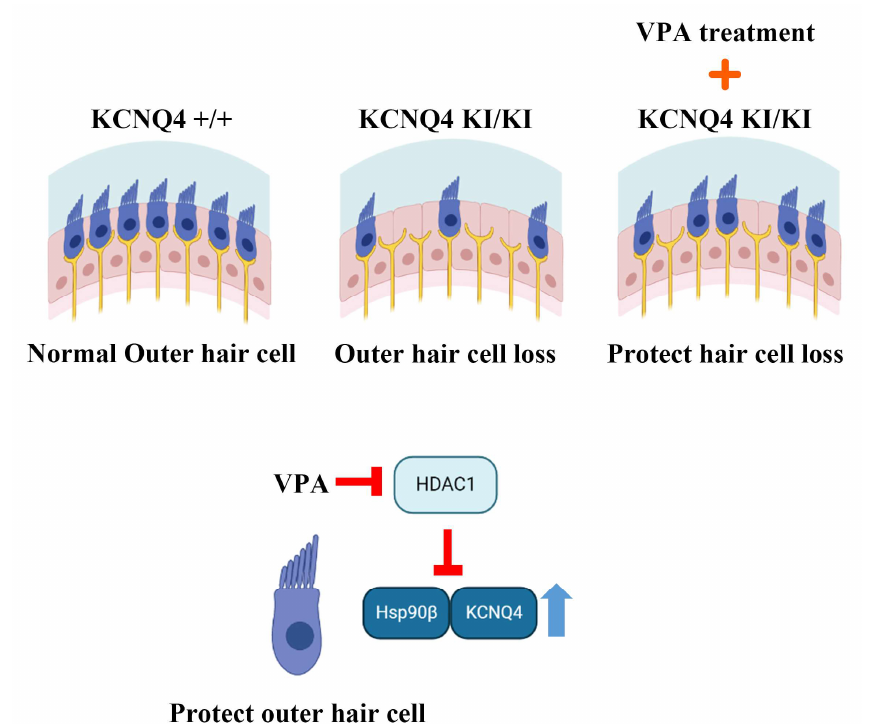
Figure 6. Schematic Diagram of VPA protecting against KCNQ4 variant-induced hair cell loss. KCNQ4 p.W276S variant induced outer hair cell loss, which was protected by a VPA treatment increase in HSP90β KCNQ4 binding, with expression through the inhibition of HDAC1 activation.